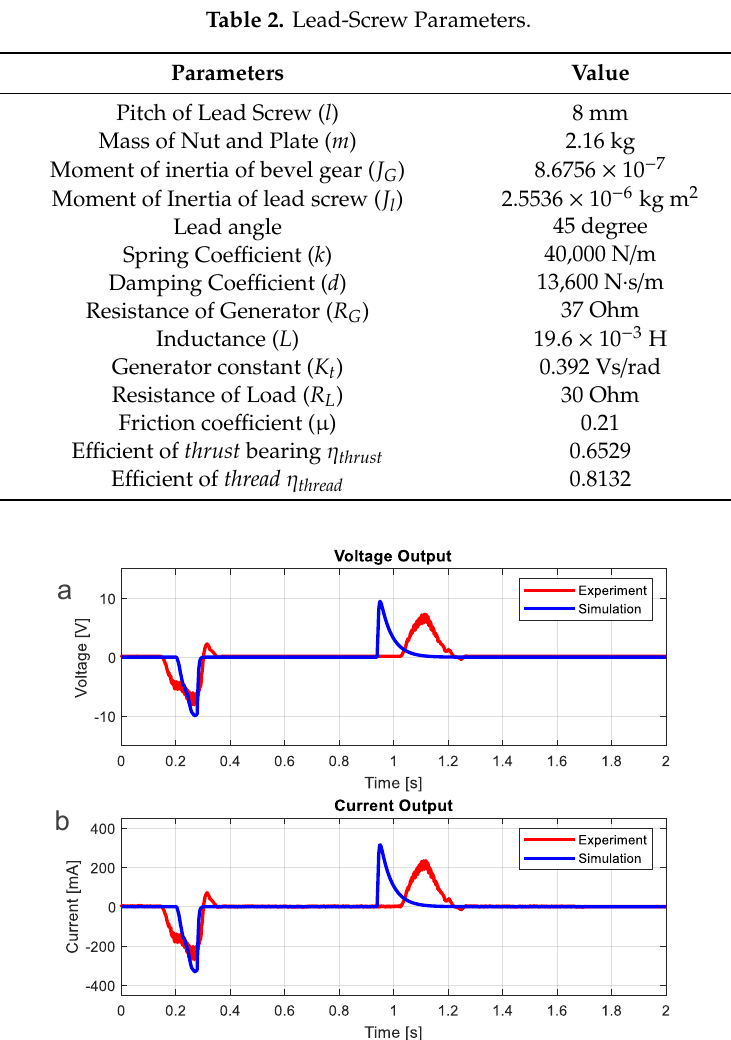
Table 1. Rack-Pinion Parameters.